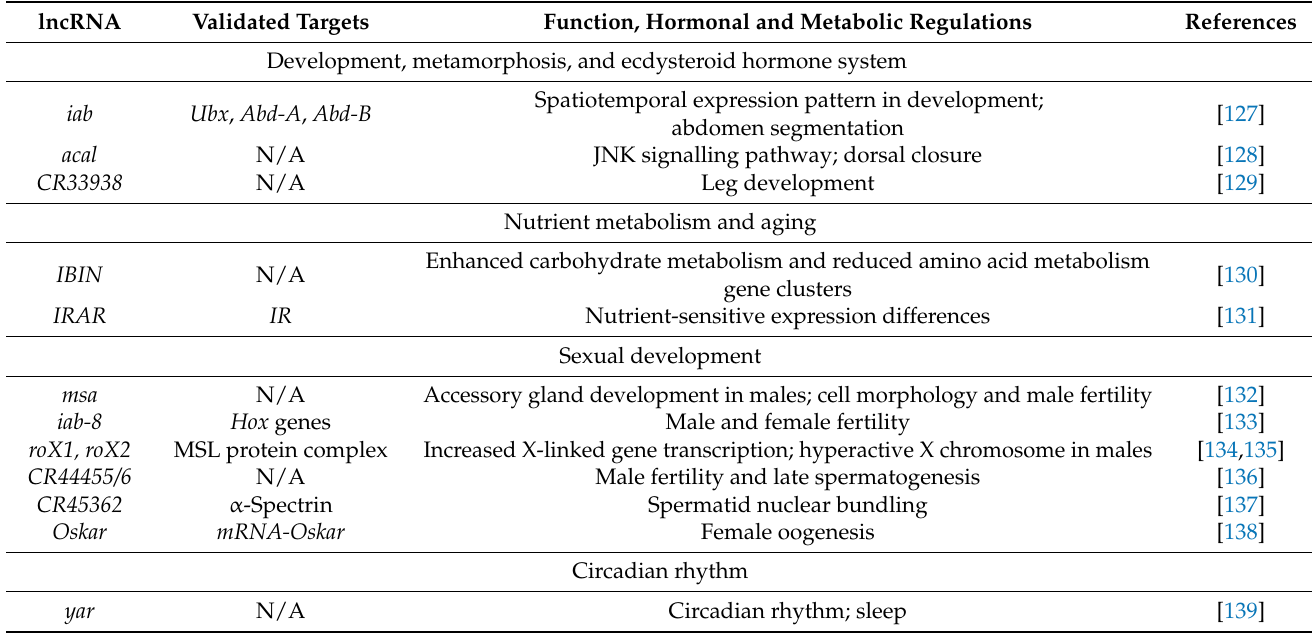
Table 2. Summarisation of lncRNAs reported with their validated targets, function, and hormonal and metabolic regulations according to their